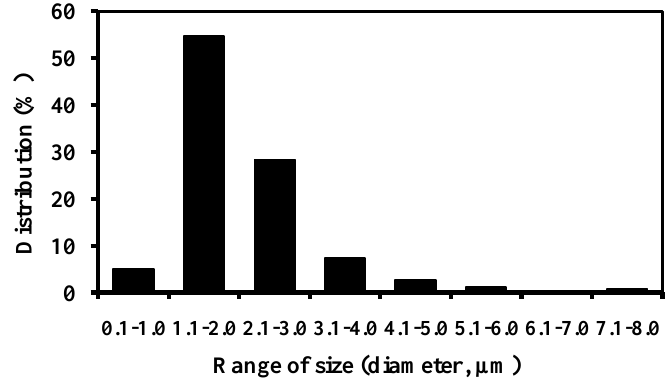
Figure 2. The size distribution pattern of poly(nBA-NAS) microspheres synthesized via photopolymerization